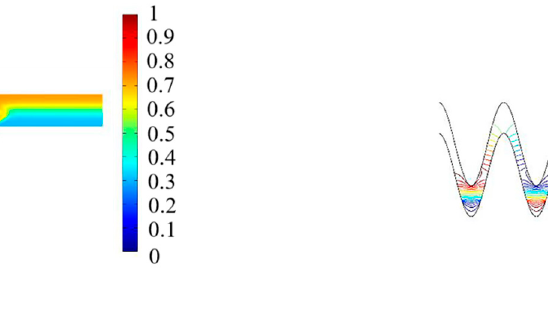
Figure 7. Simulation of the electroosmotic micromixer: ( a ) distribution of concentration surface along the micromixer, ( b ) electric potential streamlines when time t = 1 s, phase shift of pi/4, U 0 = 0.1 mm/s, V 0 = 2 V, f = 5 Hz.